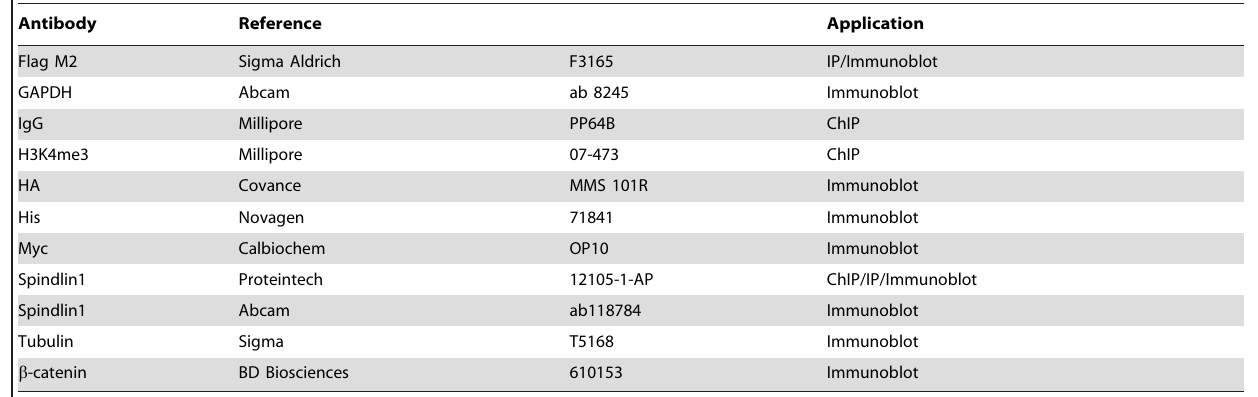
Table 1. Antibodies.